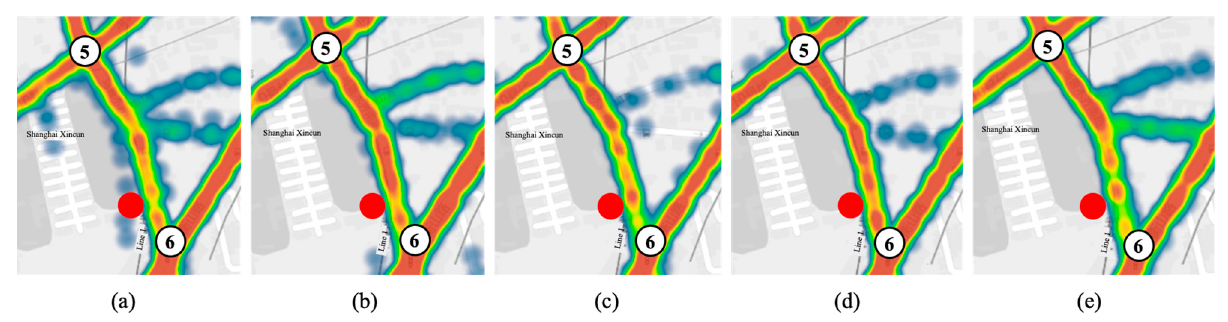
Figure 3. Heat map of peak hour traffic flow on the link where the POI is located: ( a ) 15:15~15:30; ( b ) 15:30~15:45; ( c ) 15:45~16:00; ( d ) 16:00~16:15; ( e ) 16:15~16:30.